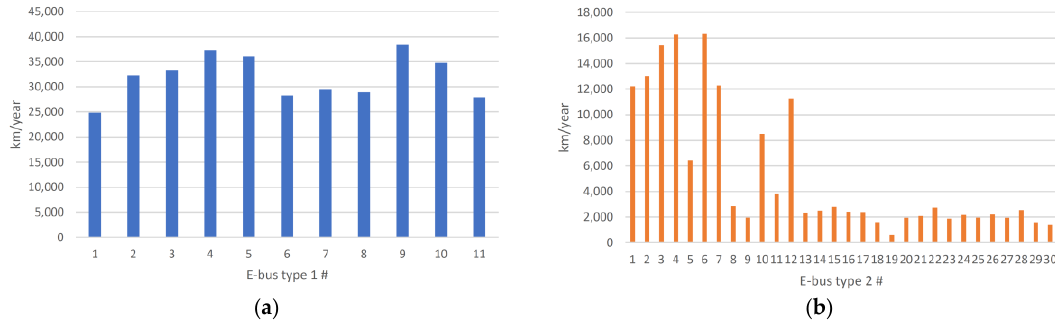
Figure 3. Number of kilometers traveled annually per each e-bus: ( a ) LiFePO 4 battery bus type; and ( b ) NMC battery bus type.